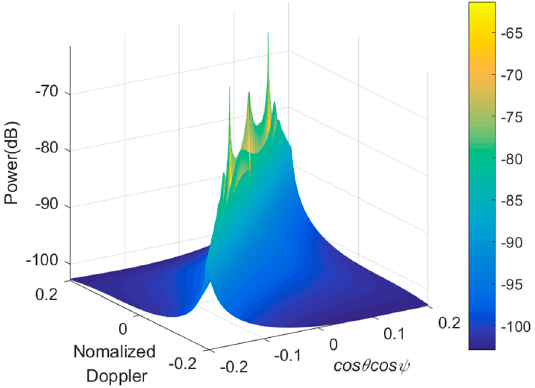
Figure 12. MV spectrum of clutter estimated by samples of 20th to 50th range gates, where refers to both runway and lawn surface.